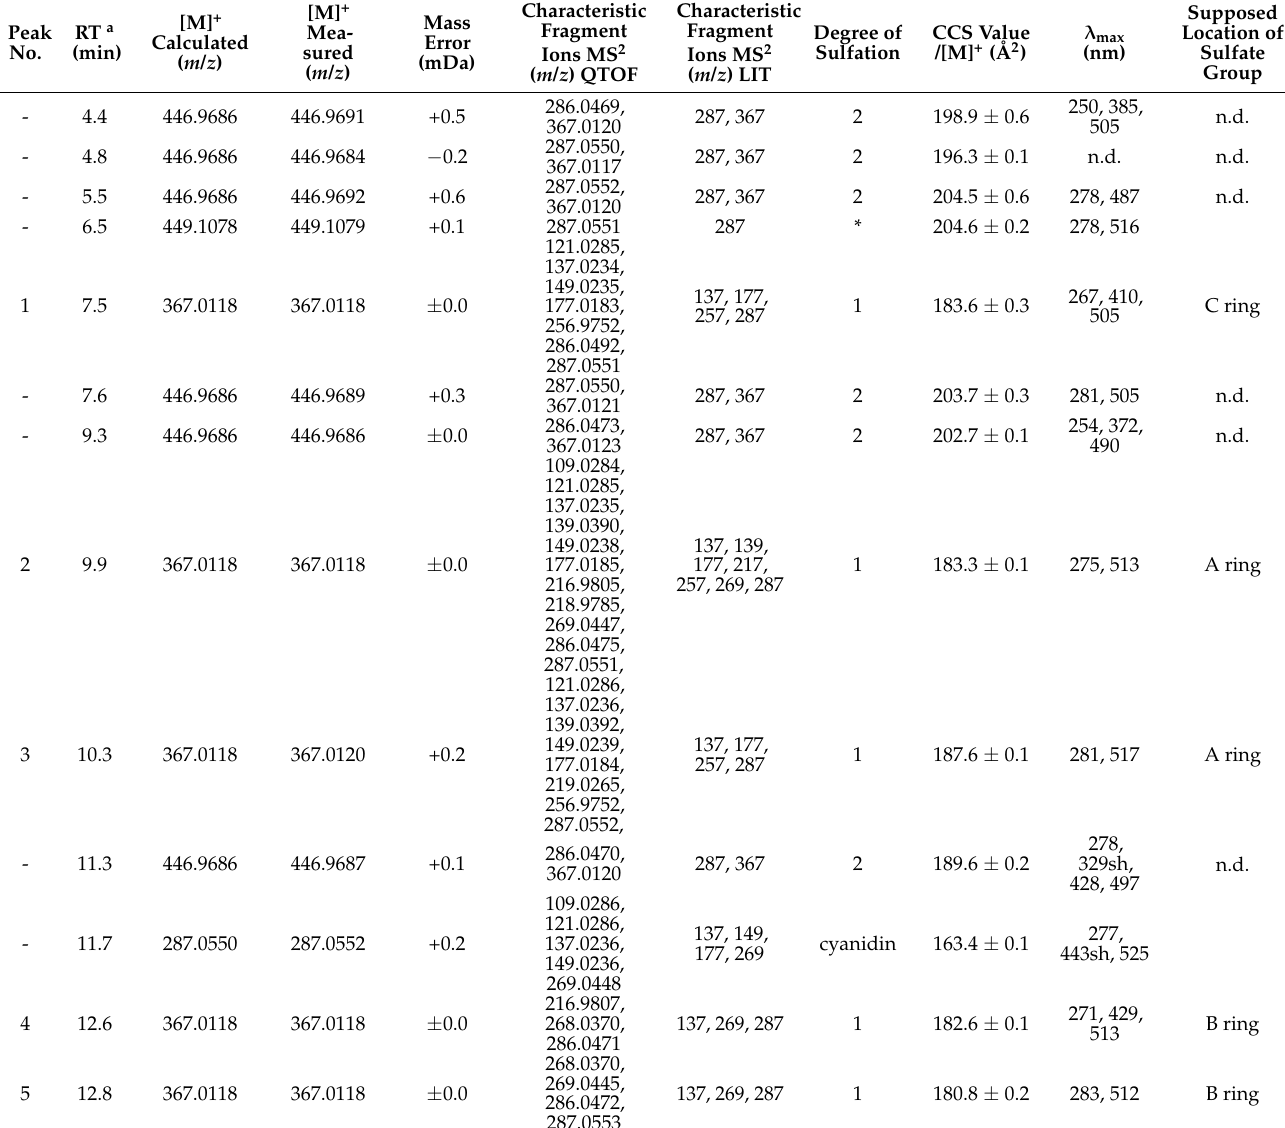
Table 1. LC-DAD-ESI-LIT and LC-DAD-ESI-IMS-QTOF results of the synthesis reaction of cyanidin sulfates. Peak